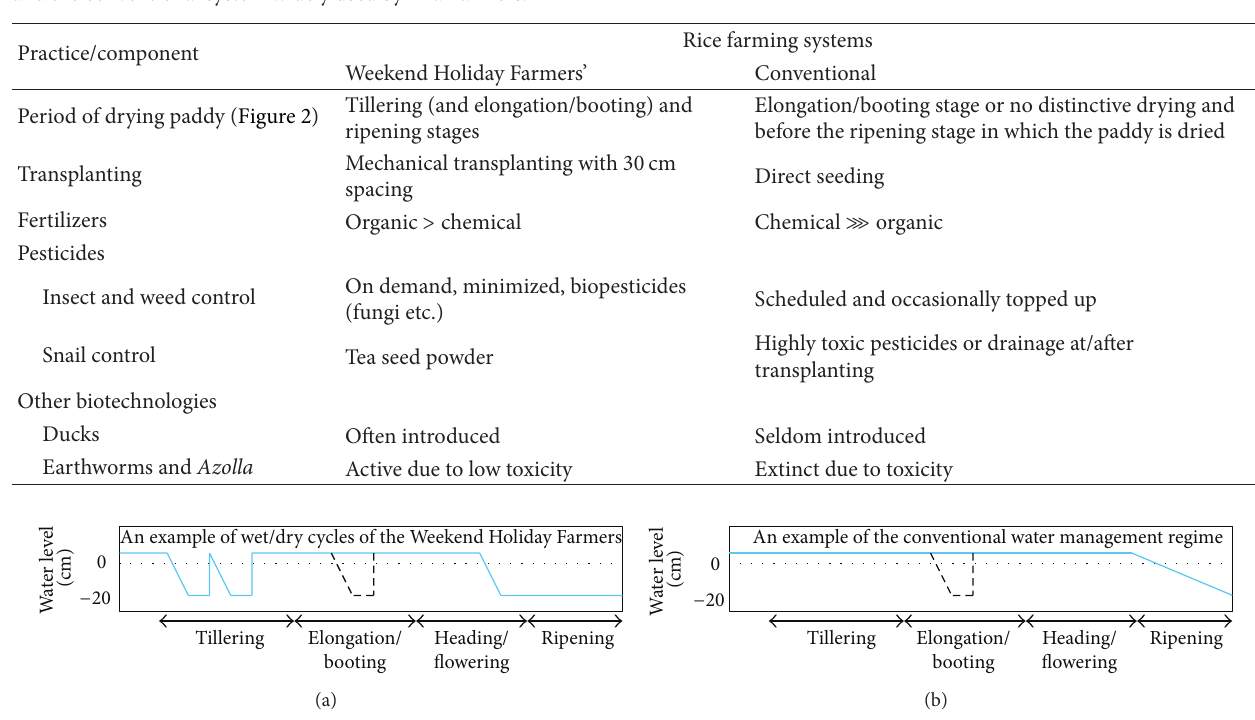
Table 1: Differences in management practice between the current rice farming system introduced by the Weekend Holiday Farmers’ Network and the conventional system widely used by Thai farmers.